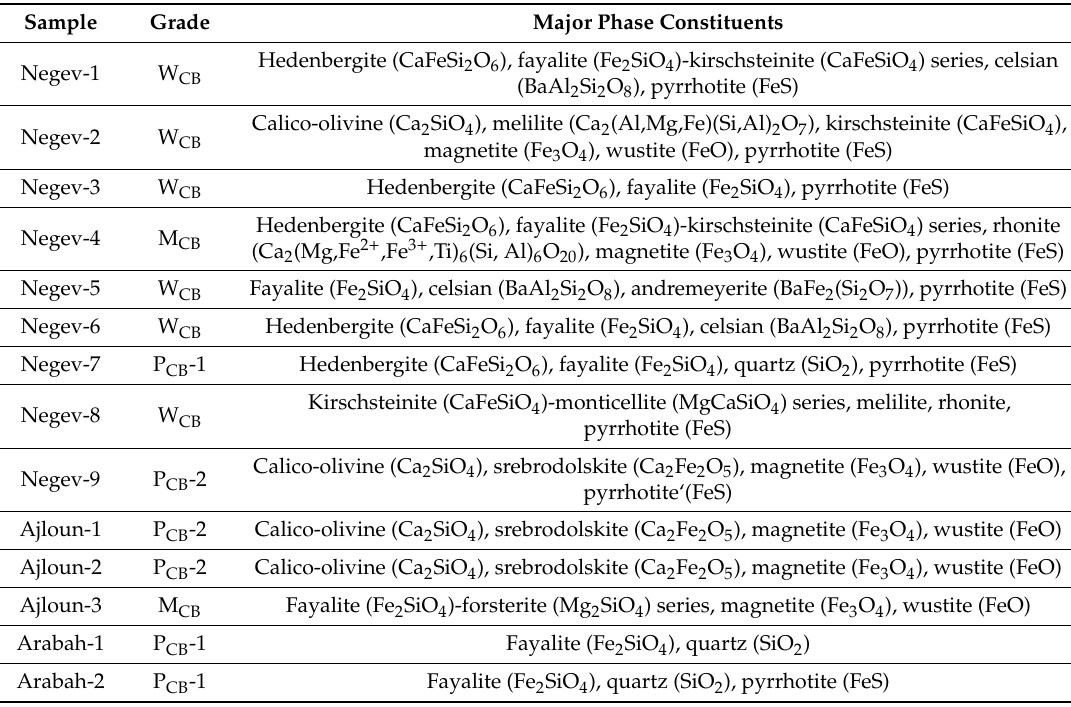
Table 5. Major phase constituents of slag from assayed blooms as determined by SEM-EDS analyses.